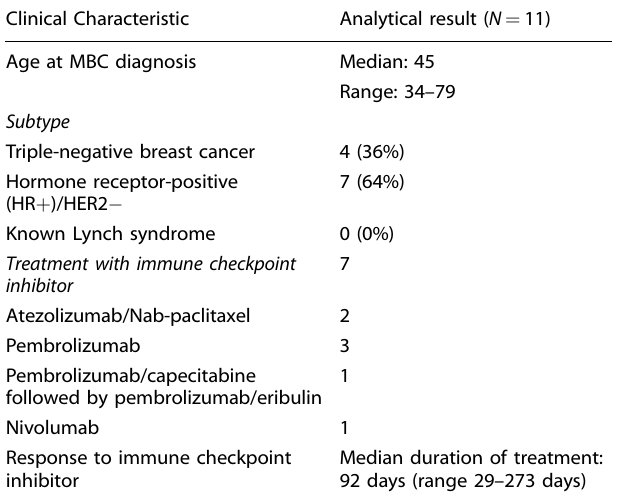
Table 1. MSI-H patients with MBC for whom clinical data was available ( N =